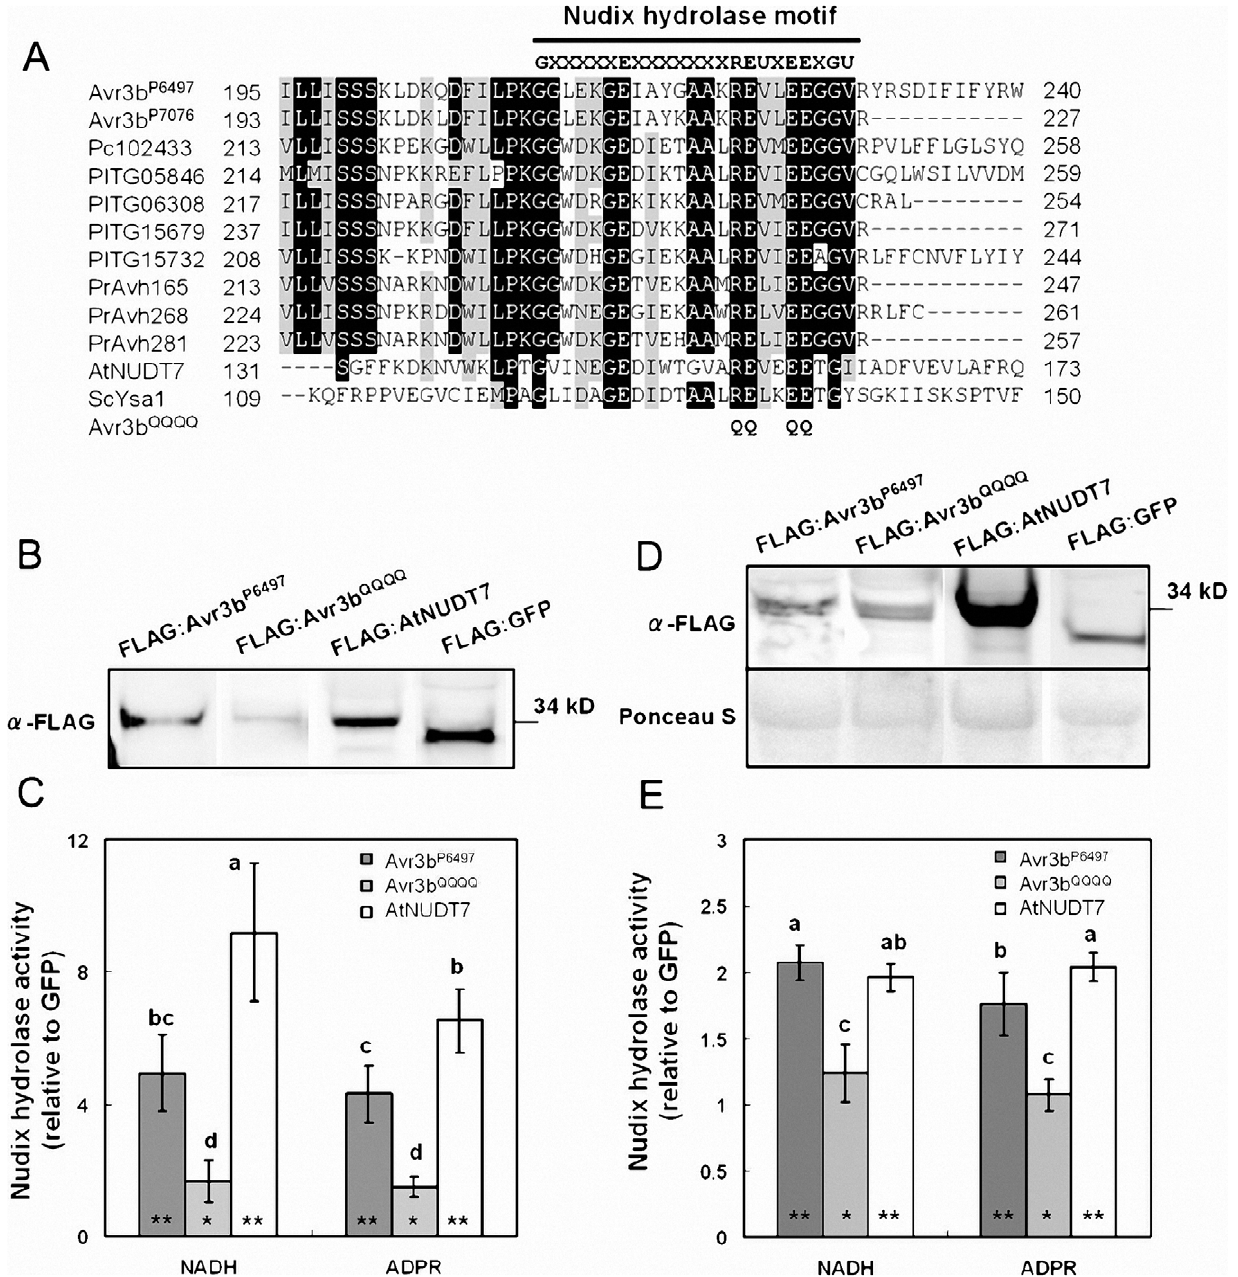
Figure 4. Avr3b is an ADP-ribose/NADH pyrophosphorylase. ( A ) Sequence alignment of the Nudix motif region from Avr3b homologs and characterized nudix hydrolases. Pc102433 is a predicted P. capsici RXLR effector. PITG05846, PITG06308, PITG15679, and PITG15732 are predicted P. infestans RXLR effectors. PrAvh165, PrAvh268, and PrAvh281 are P. ramorum RXLR effectors. AtNUDT7 is an ADP-ribose/NADH pyrophosphorylase from Arabidopsis. ScYSA1 is an ADP-ribose pyrophosphorylase from Saccharomyces cerevisiae. The black line refers to the Nudix hydrolase motif ‘‘G5XE7XREUXEEXGU.’’ The threshold for amino acid shading in this alignment is 70%. Avr3b QQQQ is an Avr3b P6497 non-functional mutant; the glutamine (Q) substitutions in the nudix hydrolase motif are marked. ( B ) Western blot of purified Avr3b and control proteins. Immuno-precipitated recombinant proteins FLAG:AtNUDT7, FLAG:GFP, FLAG:Avr3b P6497 and predicted non-functional Avr3b mutant FLAG:Avr3b QQQQ were detected with anti-FLAG antibody. ( C ) Enzyme assays of purified Avr3b and control proteins. The hydrolase activities of FLAG:AtNUDT7, FLAG:Avr3b P6497 and FLAG:Avr3b QQQQ were measured separately with FLAG:GFP as a control for each assay. The relative hydrolase activity was calculated as a ratio of Avr3b/AtNUDT7 over GFP. ADPR: adenosine diphosphate ribose, NADH: nicotinamide adenine dinucleotide (reduced form). Bars represent standard errors from 6 independent replicates each. Student’s t-test was used to compare whether testing sample activities are significantly different from the GFP control. The double asterisk and single asterisk indicates statistical significance p , 0.01 and p , 0.05, respectively. The letters represent statistical significance (P , 0.01) as measured by Duncan’s multiple range test. ( D ) Western blot of the total plant extract from the Agrobacterium infiltrated region. The supernatants from FLAG:AtNUDT7, FLAG:GFP, FLAG:Avr3b P6497 and FLAG:Avr3b QQQQ transgenic N. benthamiana leaves were electrophoresed and detected with anti-FLAG antibody. ( E ) Enzyme assays of the total protein extracts from the Agrobacterium infiltrated region. The relative hydrolase activities were measured as a ratio to extracts from a GFP-expression control. Bars represent standard errors from 4 independent replicates each. Student’s t-test was used to compare whether testing sample activities are significantly different from the GFP control. The double asterisk and single asterisk indicates statistical significance p , 0.01 and p , 0.05, respectively. The letters represent statistical significance (P , 0.01) as measured by Duncan’s multiple range test. doi:10.1371/journal.ppat.1002353.g004 PLoS Pathogens |